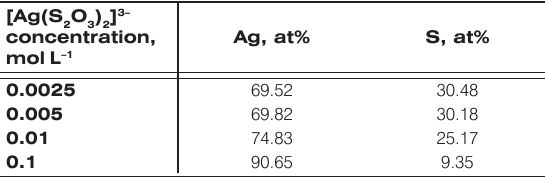
indexes, experimental and calculated values for Bragg angle of main phase (Ag (Cu-type structure, space group Fm3m , a = 0,41198(9) nm)) of deposit after 1 min cementation on magnesium disk from solution of 0.1